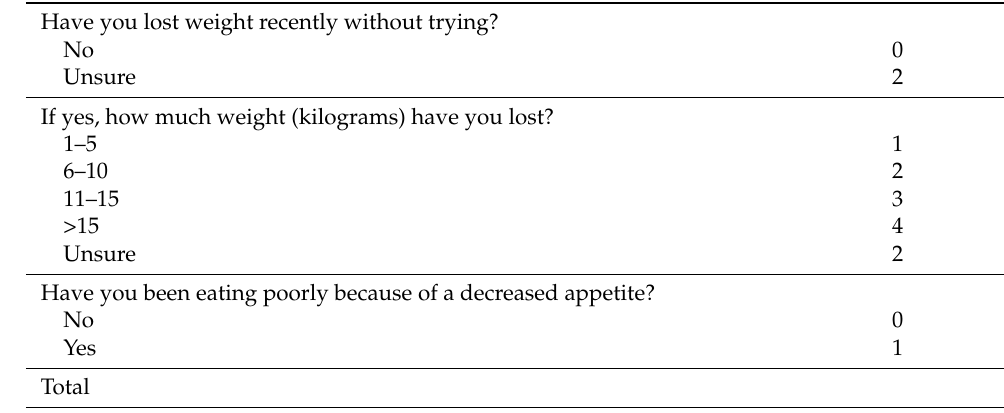
Table 3. Malnutrition Screening Tool